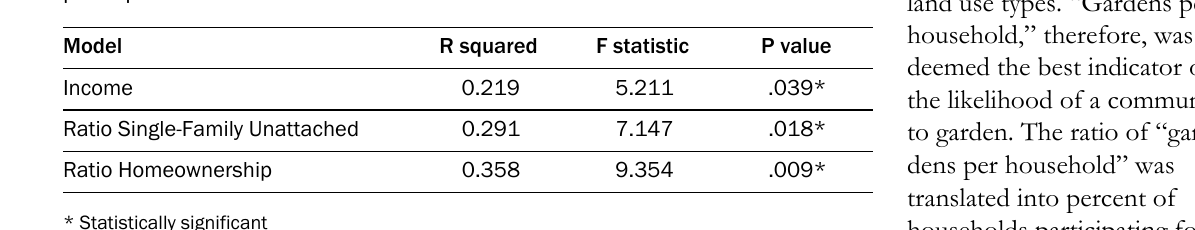
Table 2. Results of Linear Regression Models of Garden Frequency Versus Tract Characteristics